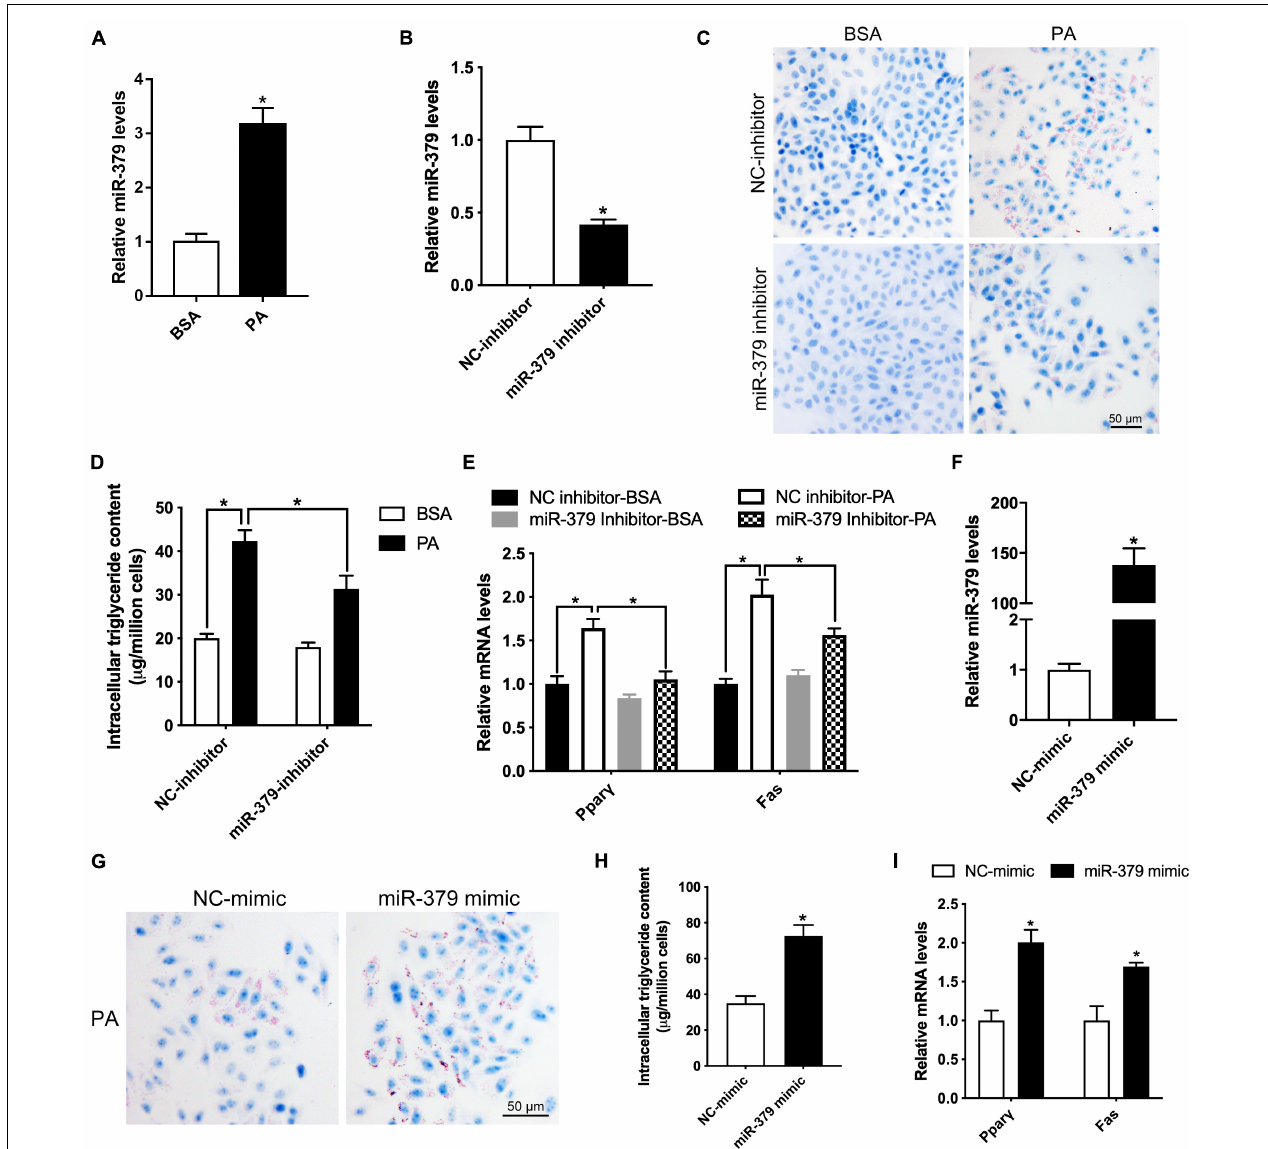
FIGURE 5 | Suppression of miR-379 expression ameliorates palmitic acid-induced lipid accumulation in HepG2 cells. (A) Histogram showing the relative expression of miR-379 in HepG2 cells ( n = 4) treated with BSA or 300 µ M palmitic acid (PA) for 24 h. *P < 0.05. (B) Histogram showing the relative expression of miR-379 in HepG2 cells ( n = 3) transfected with miR-379 inhibitor or negative control (NC) for 48 h. *P < 0.05. (C–E) Oil-red O staining (C) , intracellular triglyceride content (D) , and RT-qPCR analysis of Ppar γ and Fas (E) in HepG2 cells ( n = 3) transfected with a miR-379 inhibitor or NC for 48 h in the presence of PA or not. *P < 0.05. Scale bars = 50 µ m. (F) HepG2 cells ( n = 3) were transfected with miR-379 mimic (overexpression) or related negative control (NC) for 48 h, and RT-qPCR analyzed the expression level of miR-379 . (G–I) Oil-red O staining (G) , intracellular triglyceride content (H) , and RT-qPCR analysis of Ppar γ and Fas (I) in HepG2 cells ( n = 3) transfected with a miR-379 mimic or NC for 48 h in the presence of palmitic acid. * P <